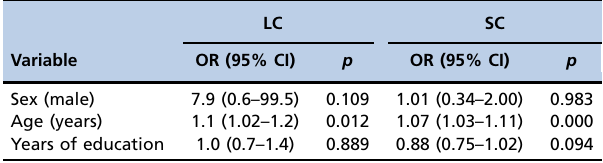
Table 2 - Estimated odds ratios for the numbers of omissions in the LC and SC based on demographic variables.